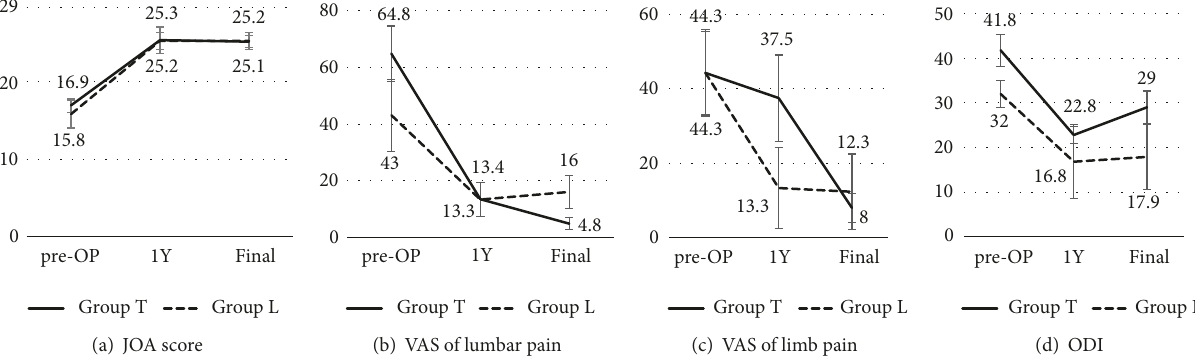
Figure 2: Mean values of clinical outcomes at preoperative, 1 year after the surgery and final follow-up of (a) JOA score, (b) VAS of lumbar pain, (c) VAS of limb pain, and (d) ODI. JOA, Japanese Orthopedic Association; VAS, Visual Analog Scale; ODI, Oswestry Disability Index.